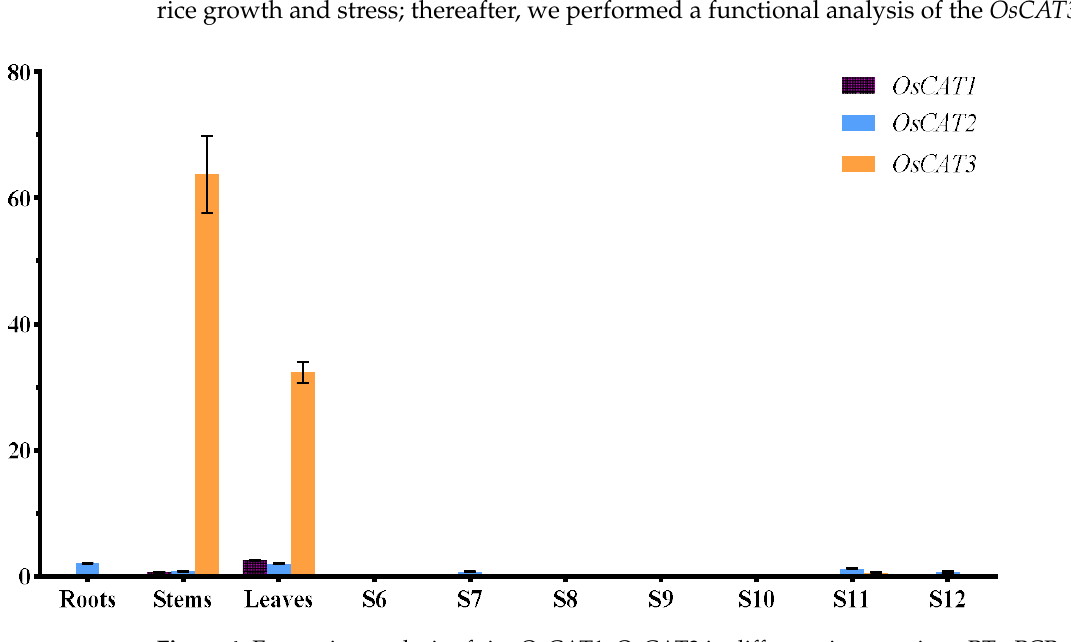
Figure 4. Expression analysis of rice OsCAT1–OsCAT3 in different tissues using qRT − PCR. S6–S12 indicate different periods of anther development. OsACTIN1 was used as the internal standard for each gene. Values indicate the means of three biological replicates ± SE.